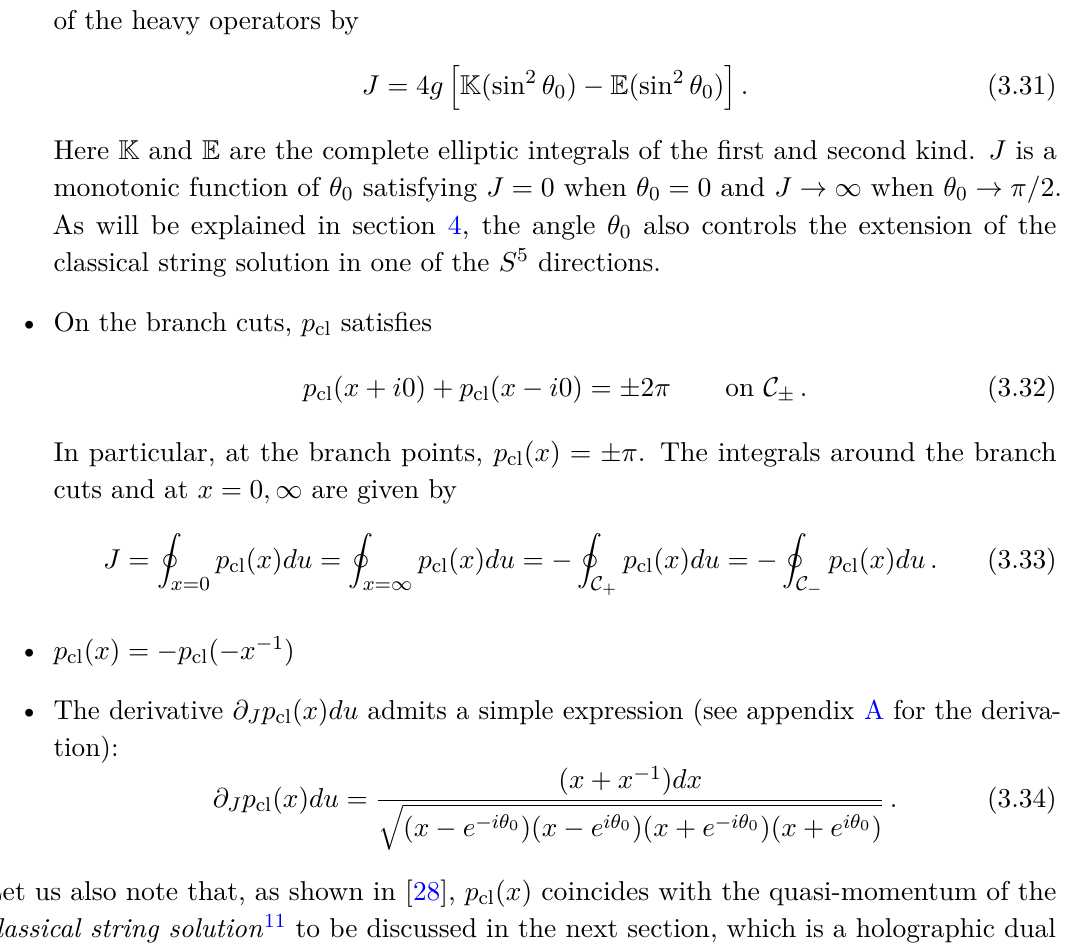
( x ) dx gives J . In cl = − π at the left branch points, − e ± iθ cl